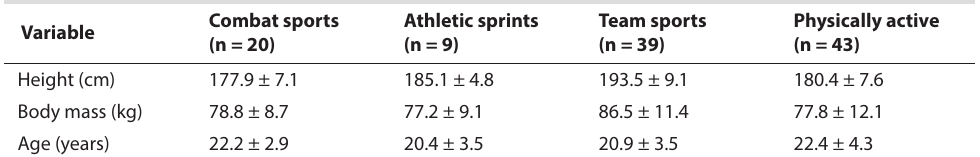
TABLE 1. Subjects’ characteristics (mean ± SD)